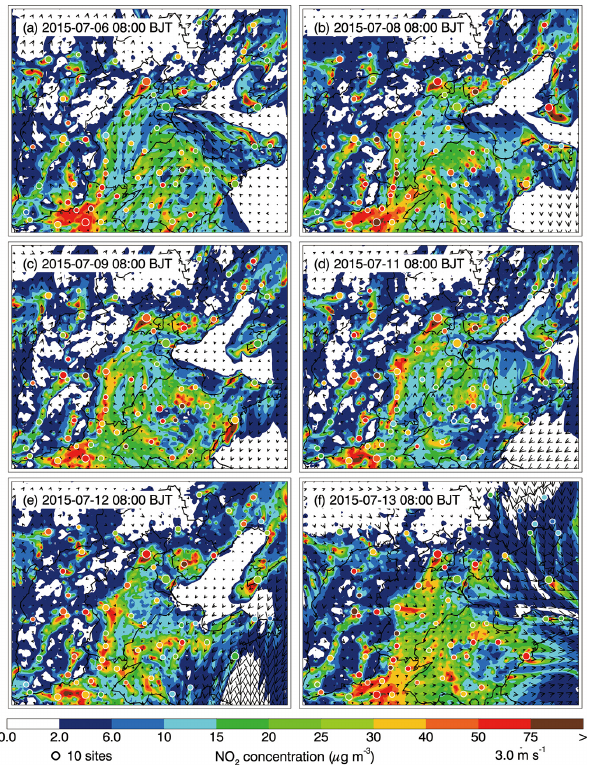
Figure 8. Same as Fig. 6, but for NO 2 at 08:00BJT.